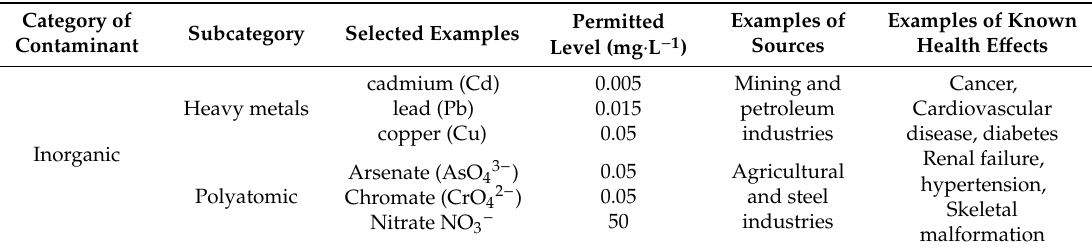
Table 1. Examples of classes of contaminants found in water sources. Sourced from Moothi et al. [5] and